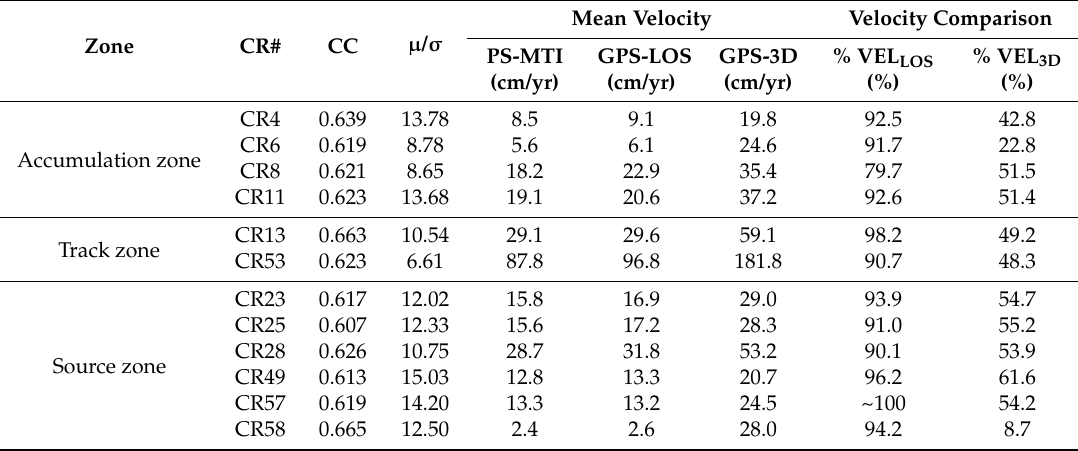
Figure 4. Plot of GPS-3D displacements ( U G ) during the period of acquisition according to a negative LOS unit vector ( n (cid:48) LOS ) on the x-axis to represent realistically its orientation in the (X, Y, Z) reference frame. According to Equation (3), ( n (cid:48) LOS ) = 100 mm for visualization purposes (UCSMP, 2016). Table 3. Comparison of coherence (CC), μ/σ ratio ( μ/σ) and mean velocities obtained by PS-MTI and GPS-LOS (and their comparison) for the period between April 2014 and July 2015.